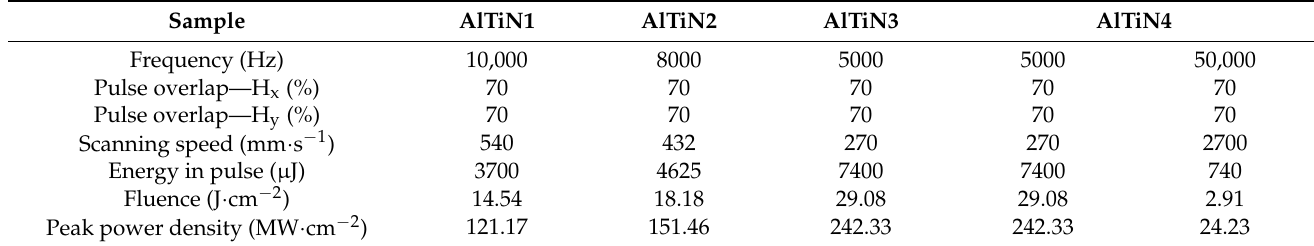
Table 4. AlTiN coating laser stripping parameters.